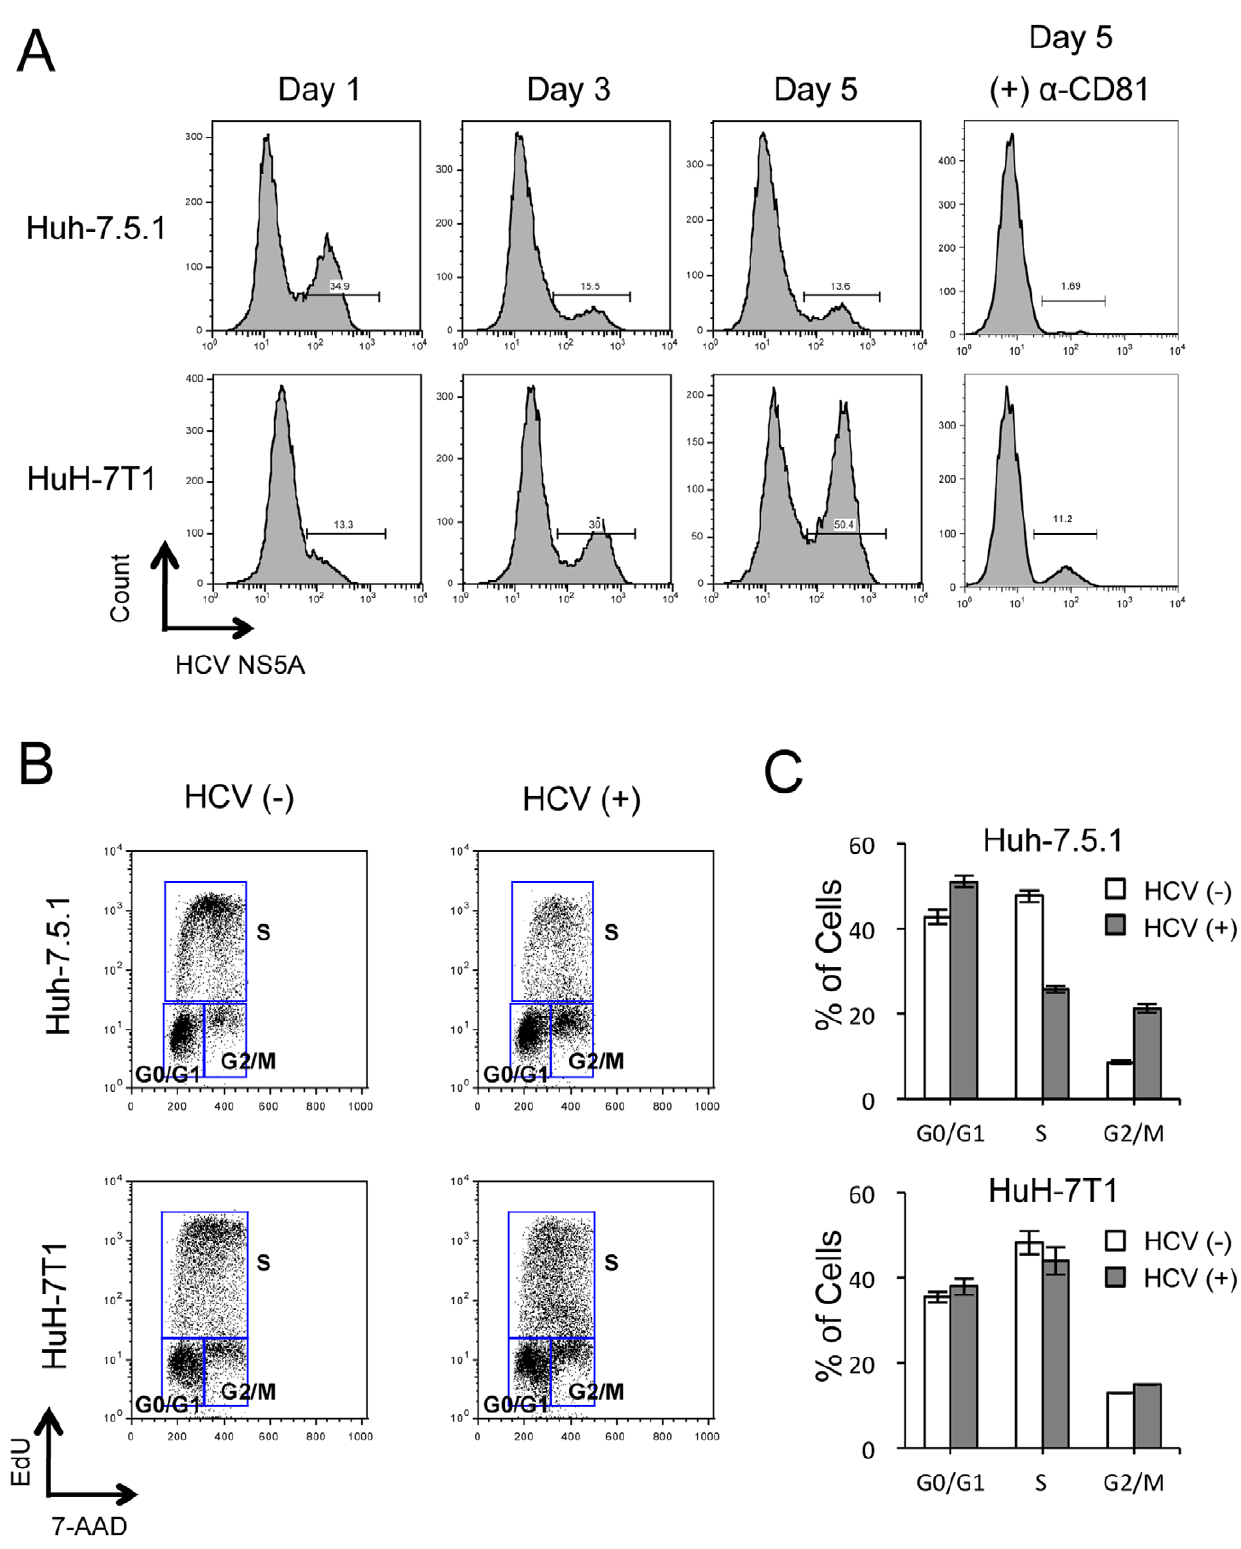
Figure 4. Effects of HCV replication on cell proliferation of Huh-7.5.1 and HuH-7T1. (A) Population of HCV-positive cells after JFH-1 RNA transfection. Two micrograms of JFH-1 RNA was electroporated into Huh-7.5.1 and HuH-7T1 and cultured with or without 10 mg/mL of anti-CD81 antibody (clone JS-81, BD). Cells were harvested at Days 1, 3, and 5. After fixing, cells were stained with anti-NS5A antibody and analyzed by flow cytometry. (B, C) Cell cycle distribution of HCV-positive and -negative cells after JFH-1 RNA transfection. Two micrograms of JFH-1 RNA was electroporated into Huh-7.5.1 and HuH-7T1. Cells were pulse-labeled with EdU and analyzed for cell cycle distribution. The percentages of cells in G0/